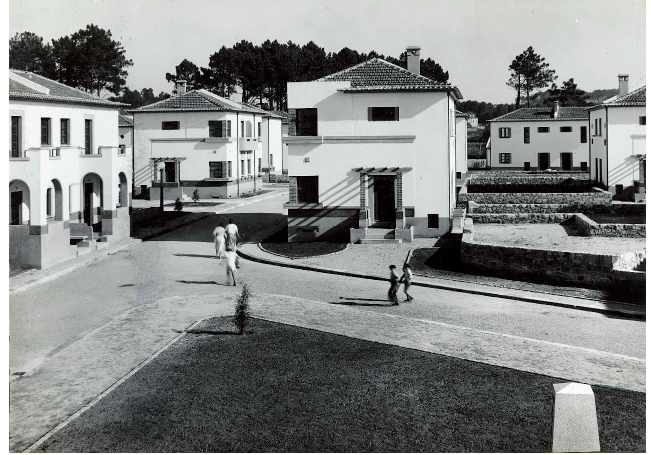
Figure 6. Affordable Houses Estate of Amial, Porto, Portugal: view of the 2nd phase houses (1955–58).